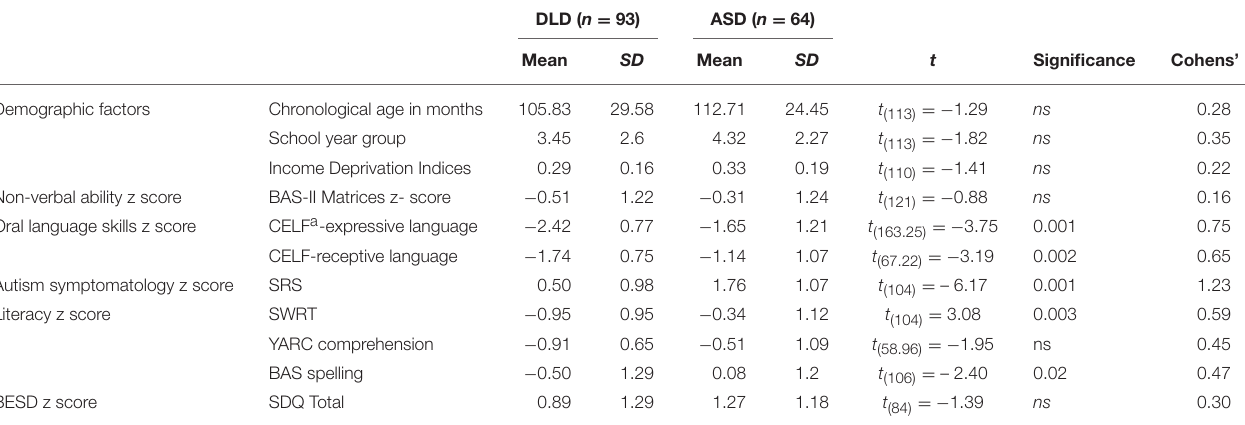
TABLE 1 | Participant characteristics for DLD and ASD